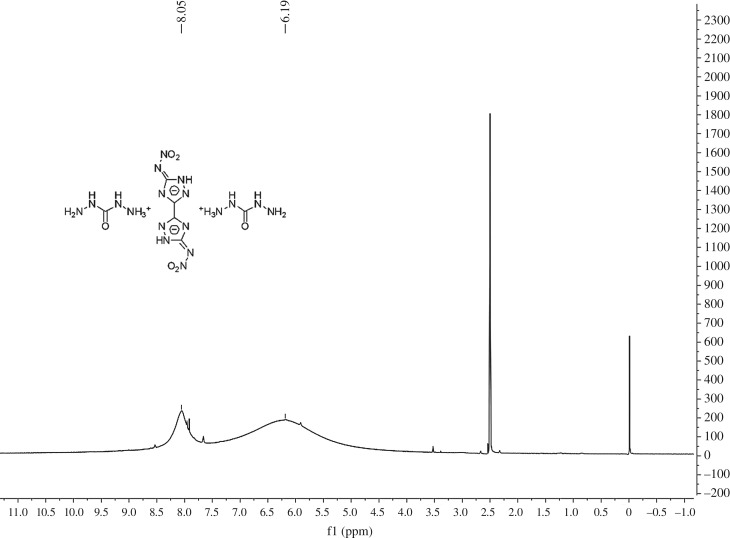
1H NMR spectrum of DCBNT.